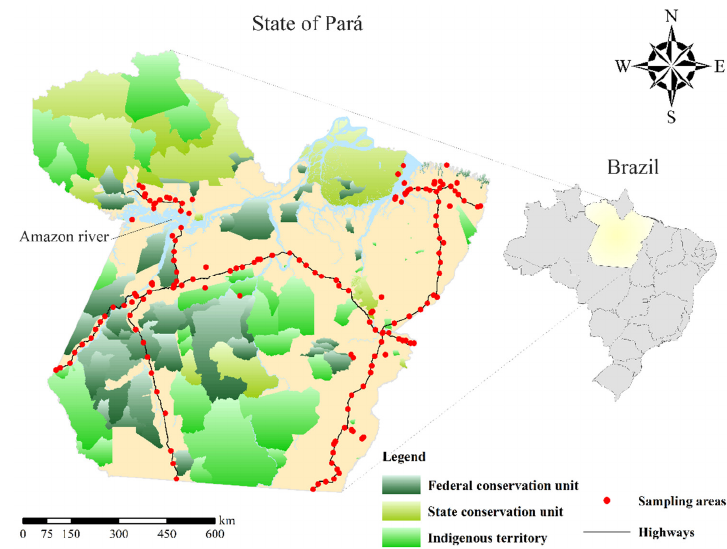
Figure 1. Distribution of samples collected in the State of Pará.